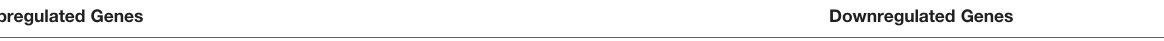
TABLE 3 | Summary of differentially expressed genes in tolDC. Upregulated Genes